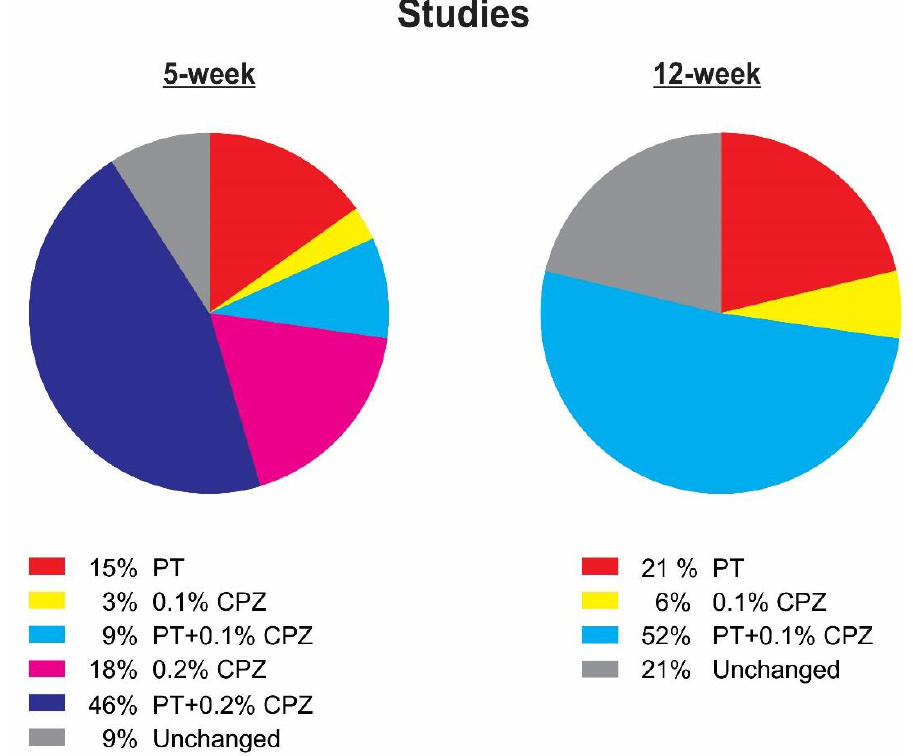
Figure 7. Highest fold change. Pie charts showing the highest increase or decrease fold change in abundance of the 33 proteoforms relative to Ctrls in the 5- and 12-week studies. PT alone or when PT was combined with CPZ showed greater change than CPZ alone. Quantification is based on ≥ 1.5-fold changes.